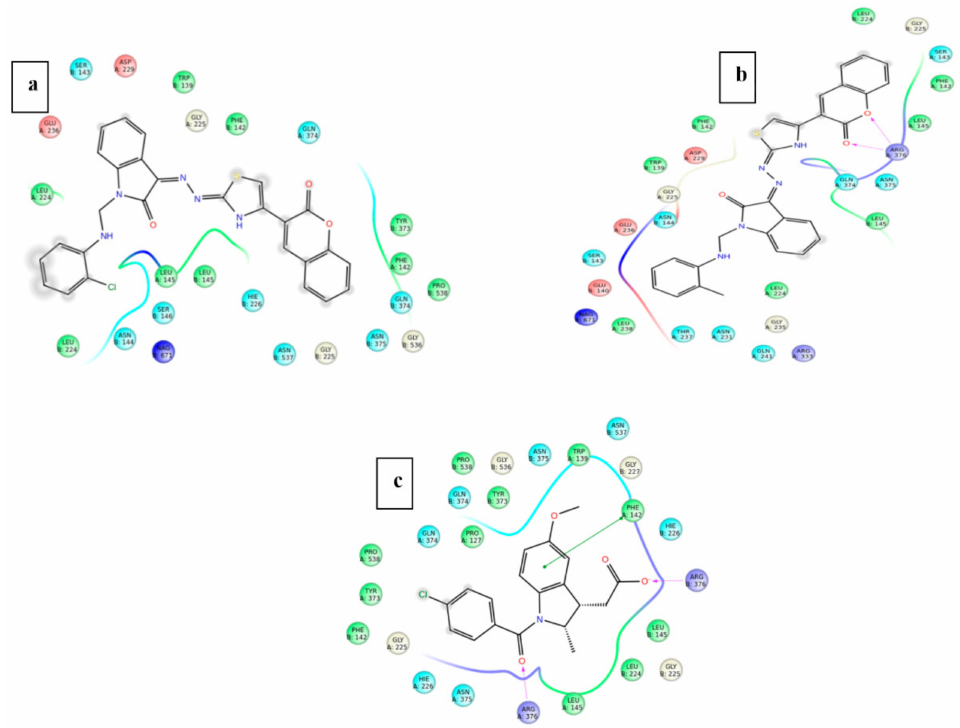
Figure 7. Ligand interaction diagram of test ligand / control drug ( a ) 4f , ( b ) 4n , ( c ) Indomethacin, with the target protein COX-2 from the mouse.